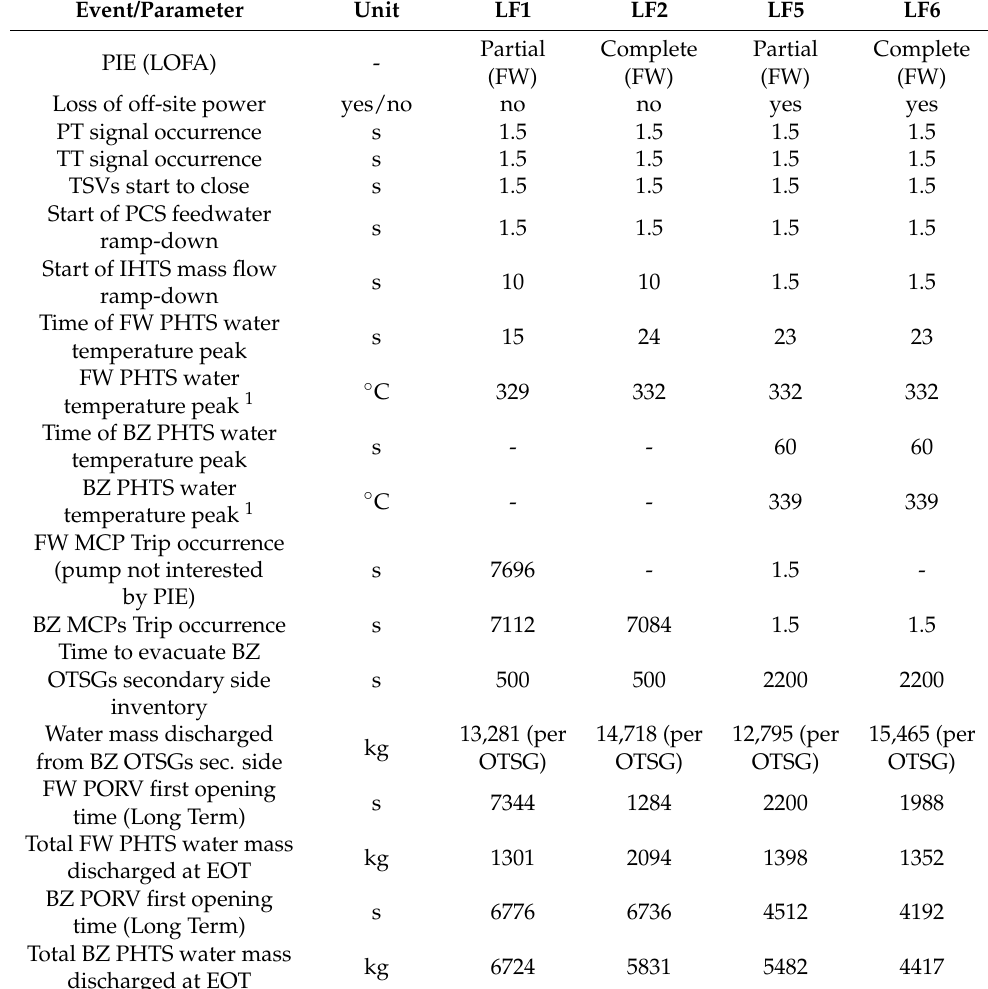
Table 7. Summary table for Loss of Flow Accidents (LOFA) involving FW PHTS Main Coolant Pumps